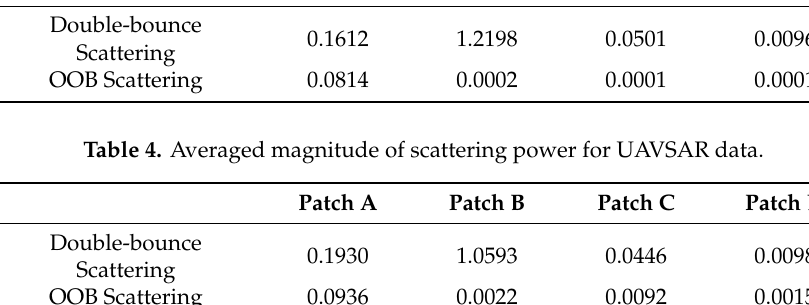
Figure 3. Extraction results using the double-bounce and OOB scattering powers. ( a )–( c ) Extraction of buildings approximately aligned with the flight trajectory (AABs), OOBs, and built-up areas for GF-3 data, respectively. ( d )–( f ) Extraction of AABs, OOBs, and built-up areas for UAVSAR data, respectively.